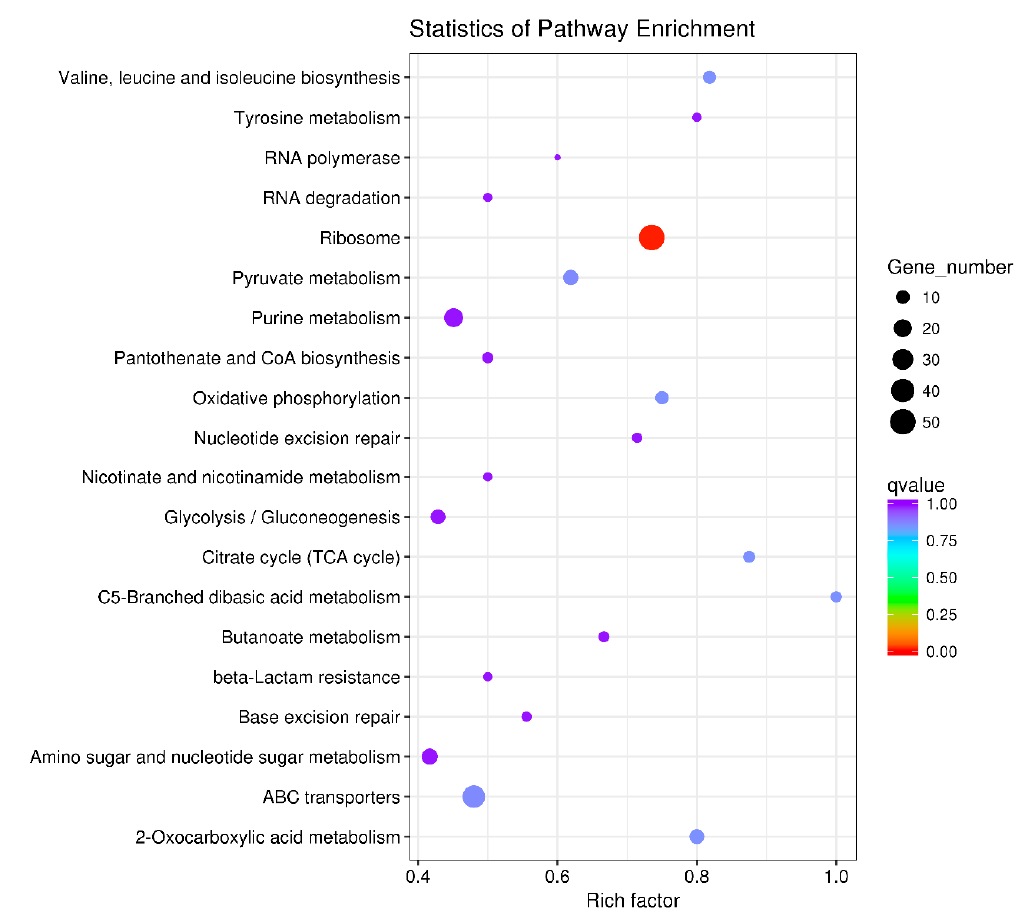
Figure 6. The top 20 KEGG pathways of the DEGs in response to ferrous iron toxicity. The size of the dot indicates the number of the DEGs enriched in the pathway, and the color indicates the q value. Rich factor was defined as the ratio of the number of the DEGs enriched in the pathway to the number of all genes annotated to this pathway. q value is the corrected P -value ranging from 0 to 1, and the lower the q value, the greater the pathway enrichment. KEGG pathway enrichment analysis was performed using the KOBAS 2.0 software with the hyper-geometric test. The KEGG pathways with a q value < 0.05 were considered to be significantly enriched.